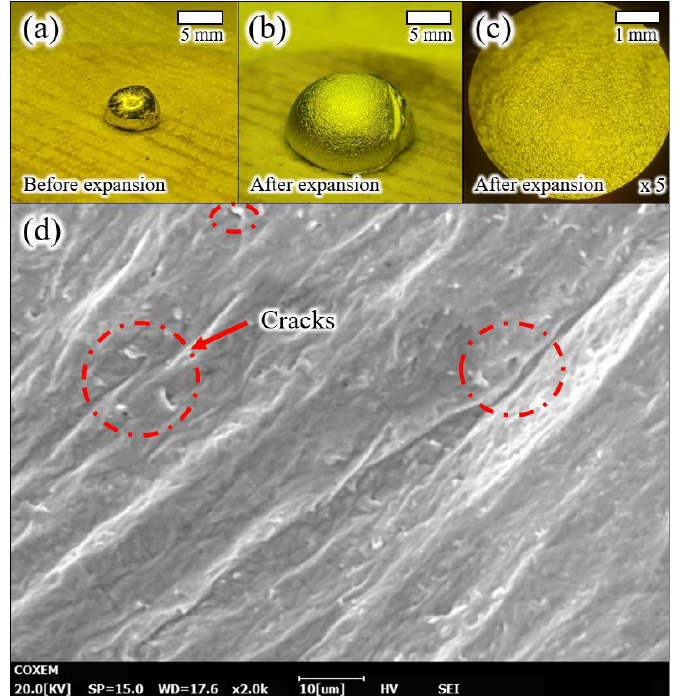
Figure 2. ( a ) An optical image of liquid metal droplets before expansion, ( b , c ) optical images of an expanded liquid metal droplet, and ( d ) SEM images of oxide cracks on an expanded liquid metal surface.